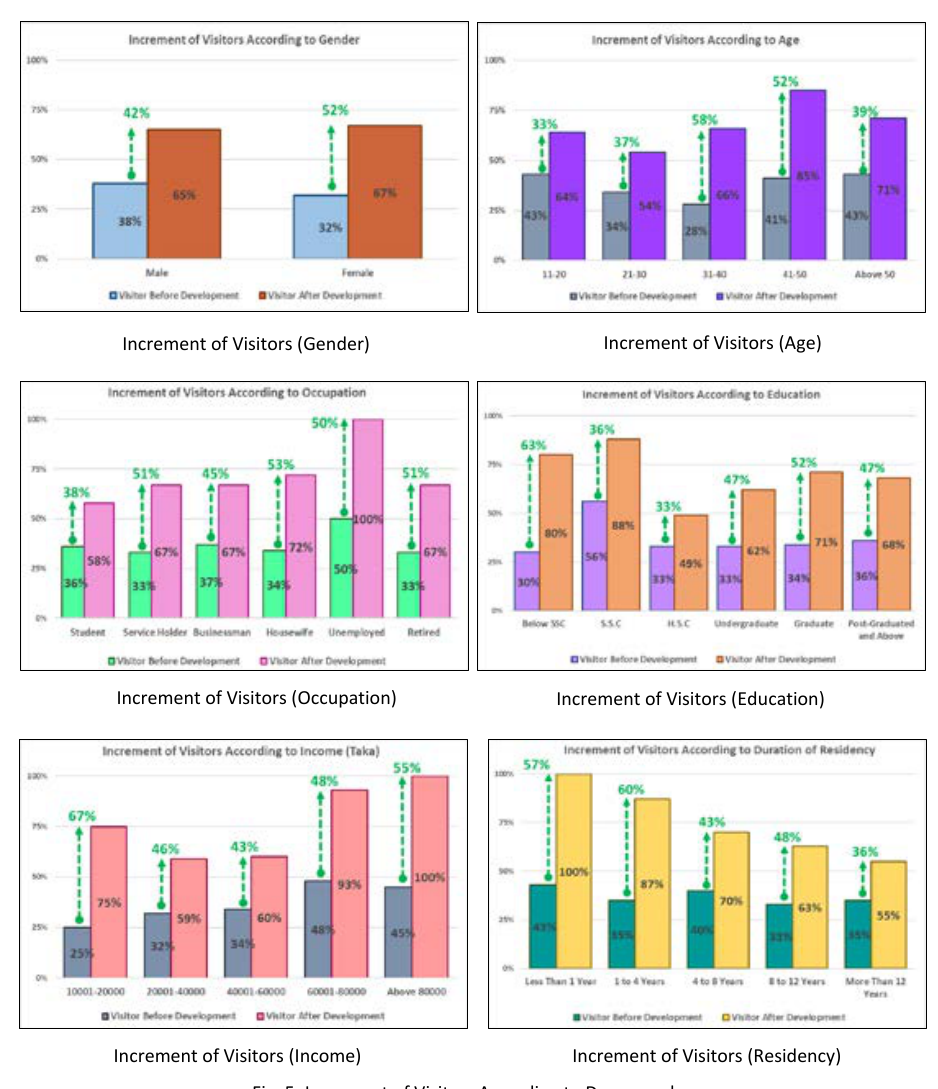
Fig. 5: Increment of Visitors According to Demography Table 4: Calculation of service area